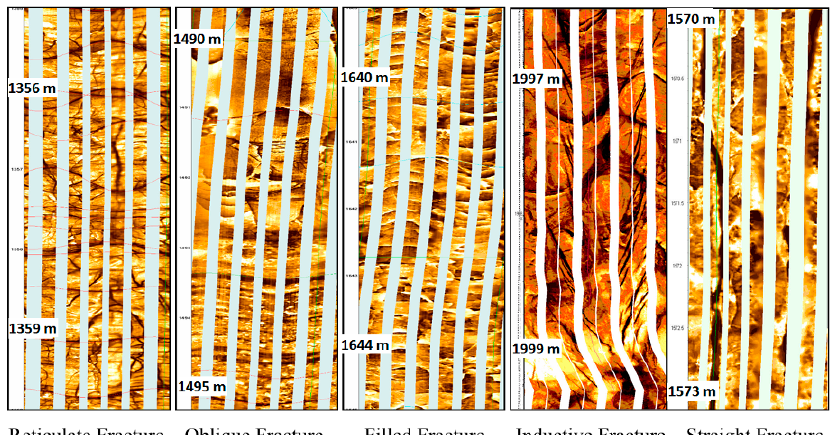
Figure 1. Several types of natural fractures based on the Formation MicroScanner Image (FMI) imaging logging.